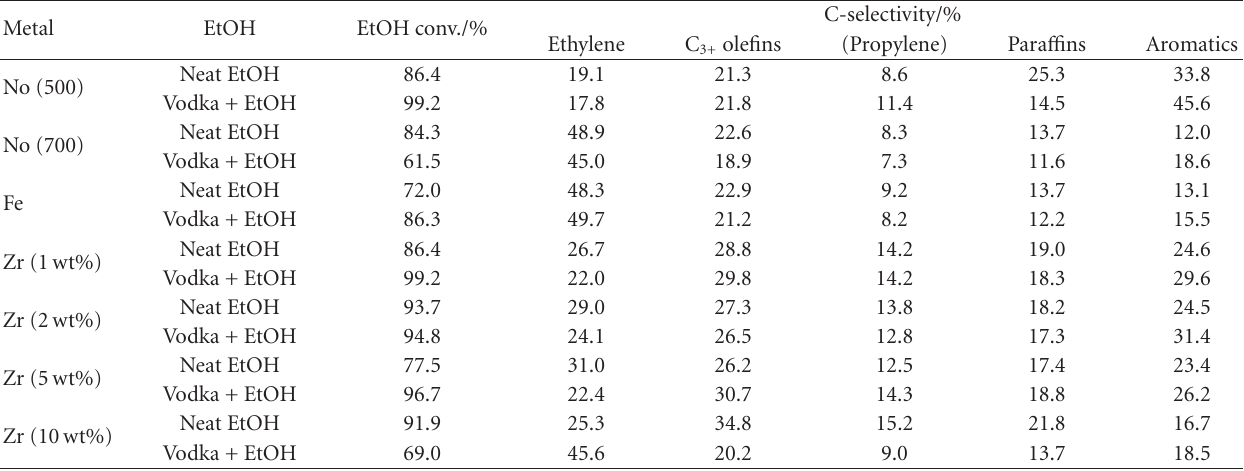
Table 1: Catalytic activity of H-ZSM-5 and (Fe or Zr)/H-ZSM-5 zeolite